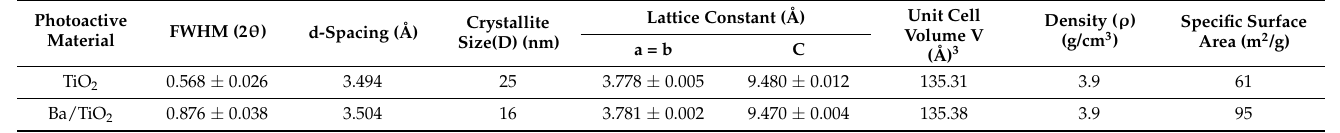
Table 1. StructuralparametersderivedfromXRDpatternsofthesynthesizedTiO 2 andBa/TiO 2 photoanode. Photoactive